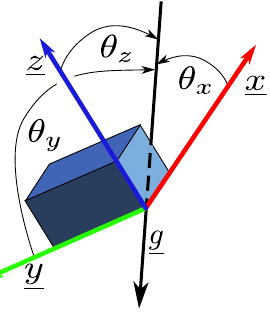
Figure 2. Orientation of the IMU with respect to a vertical axis represented by gravity ( g ) can be defined as the cosines of angles θ x , θ y and θ z